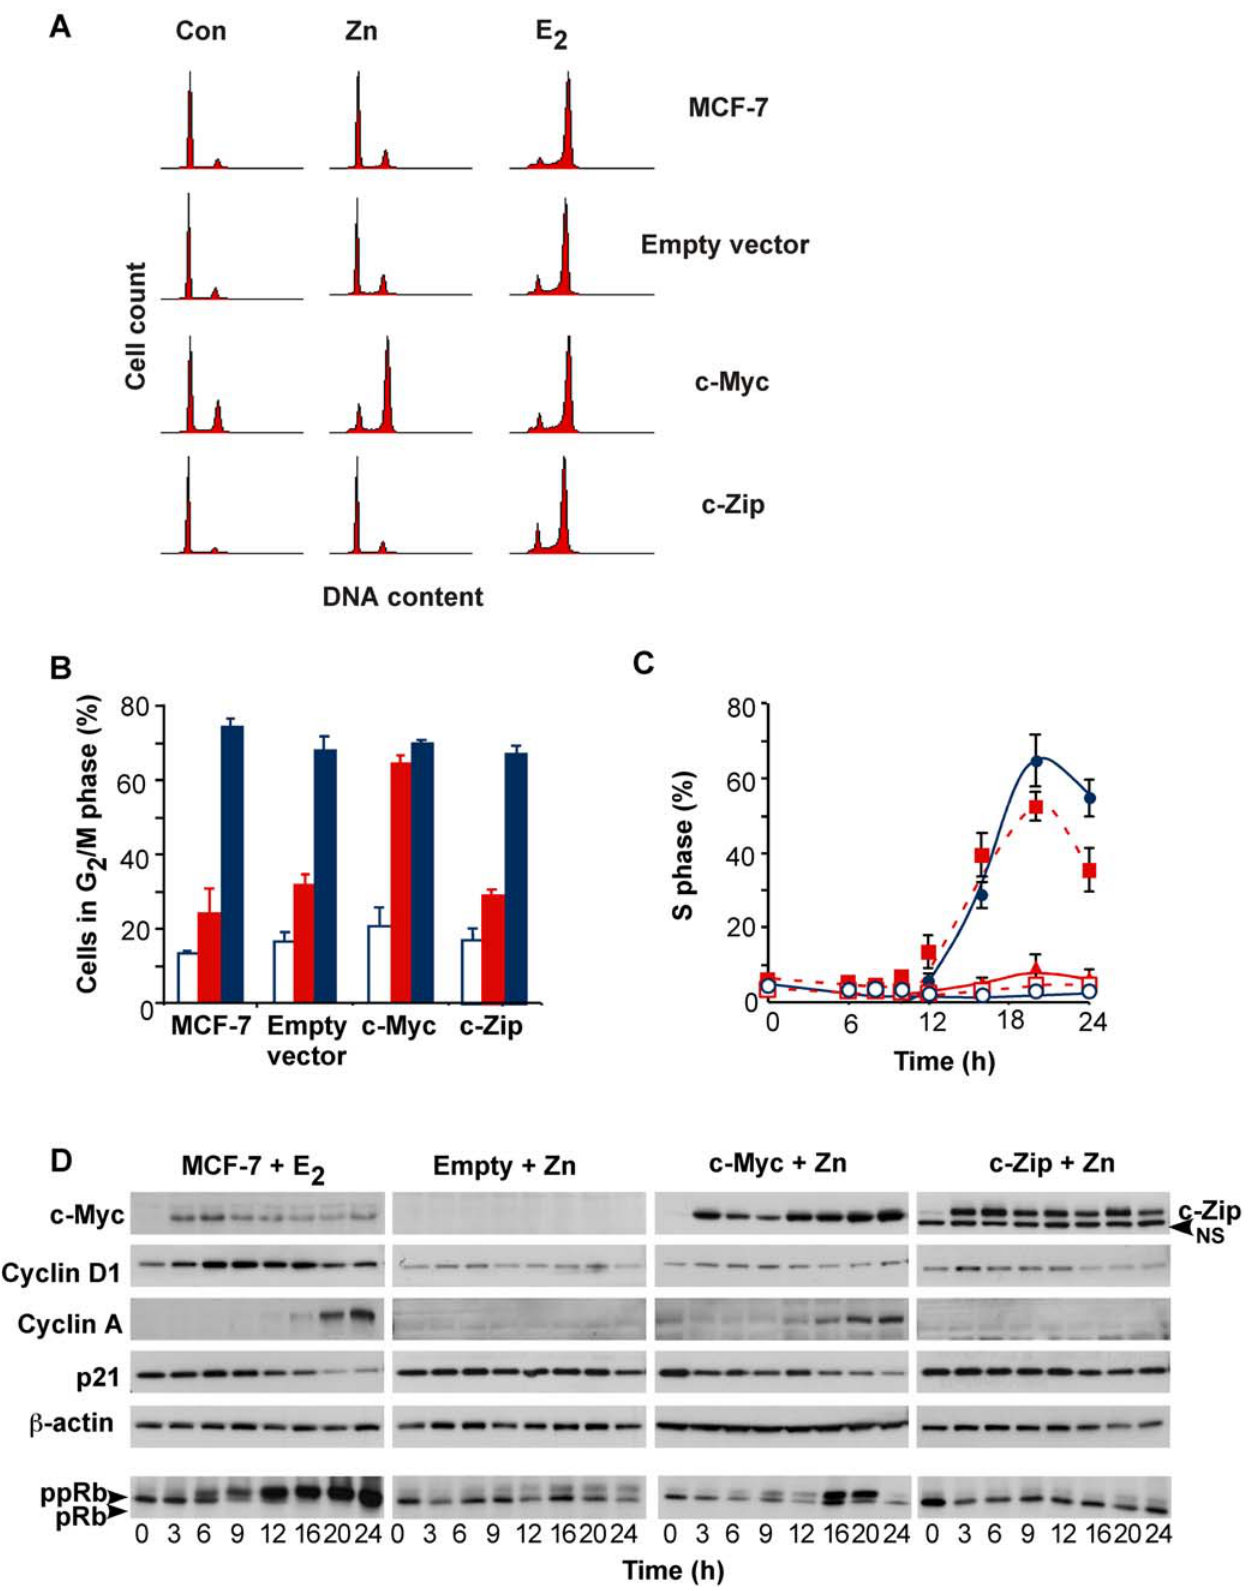
Figure 1. Effects of estrogen treatment and induction of c-Myc and c-Zip in antiestrogen-arrested cells. Cell lines stably transfected with the inducible vector p D MT containing c-Myc, a c-Myc mutant lacking the entire N-terminal domain (c-Zip) or empty vector (Empty vector) were growth arrested with 10 nM ICI 182780 for 48 h. Cells were treated at time zero with either 100 nM 17 b -estradiol (E 2 ) or vehicle (ethanol, EtOH) for